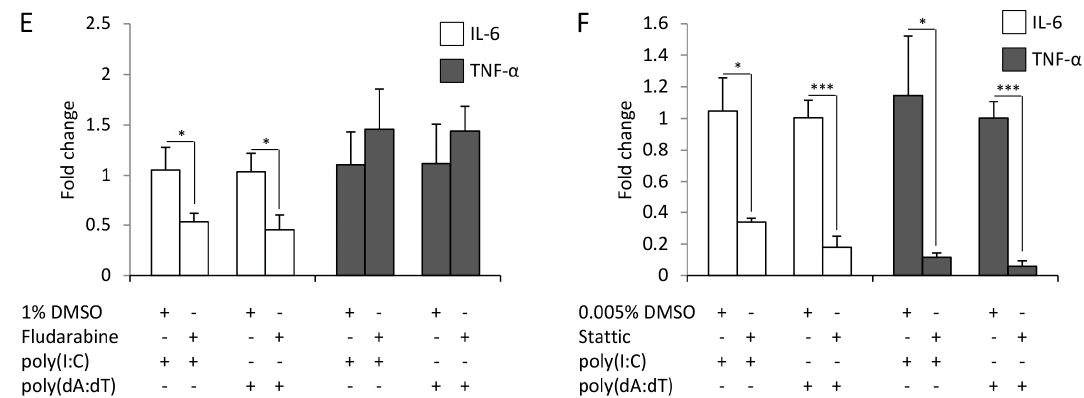
Figure 3. Inhibition of different signaling routes has divergent effects on the expression of the IL-6 (white bars) and TNF- α (grey bars) cytokines in keratinocytes. The effect of inhibition by NF- κ B ( A ), p38 ( B ), c-Jun N-terminal kinase (JNK) ( C ), mitogen-activated protein kinase kinase 1 and2 (MEK1/2) ( D ), STAT-1 ( E ) and STAT-3 ( F ) on poly(I:C) (6 h after transfection) and poly(dA:dT) (12 h after transfection) induction of IL-6 (white bars) and TNF- α (grey bars) expression in HPV-KER cells. Fold change of mRNA expression values were determined by the ΔΔ C t method, normalized to 18S rRNA expression. As all inhibitors were dissolved in dimethyl sulfoxide (DMSO), the relative mRNA expression levels were compared to the expression levels in samples treated with DMSO + poly(I:C) or DMSO + poly(dA:dT), respectively. Poly(I:C) and poly(dA:dT) induction was in every case significant compared to the untreated control samples; no significant difference was observed between the cytokine-expression level of the samples treated with poly(I:C), poly(dA:dT), DMSO + poly(I:C) or DMSO + poly(dA:dT). Data are represented as the means of three independent experiments ± standard error; * p < 0.05; ** p < 0.01; *** p < 0.001 determined by Student’s t -test.